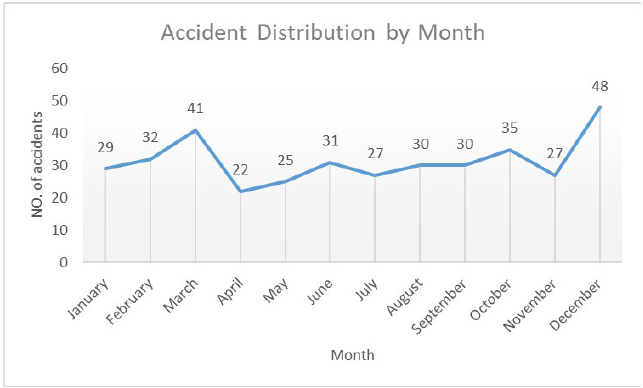
Figure 2. Accident distribution by month.